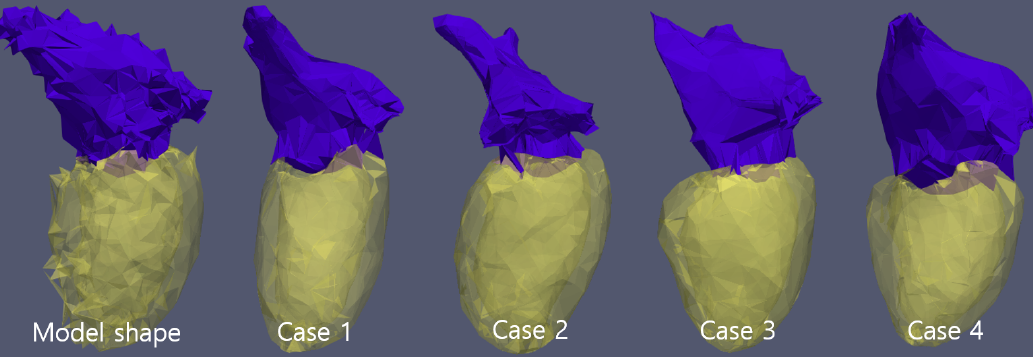
Figure 1. Volume density of appearance texture with soft correspondence of m largest selection in any case. The axial view of the left heart is shown. ( a ) m = 1. ( b ) m = 2. ( c ) m = 3. ( d ) m = 4.